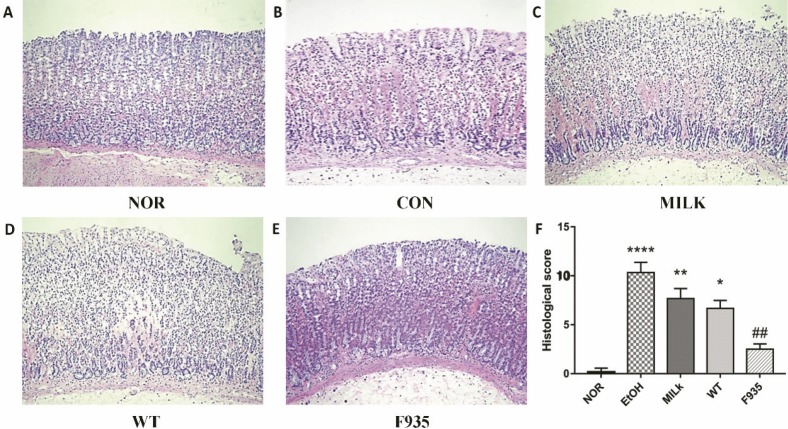
Histopathological analysis of gastric mucosa (hematoxylin and eosin staining, ×100). (A) NOR group; (B) EtOH group; (C) MILK group; (D) WT group; (E) F935 group; (F) histological score. ****p < 0.0001, **p < 0.01, and *p < 0.05 vs. the NOR group, ##p < 0.05 vs. the EtOH group.